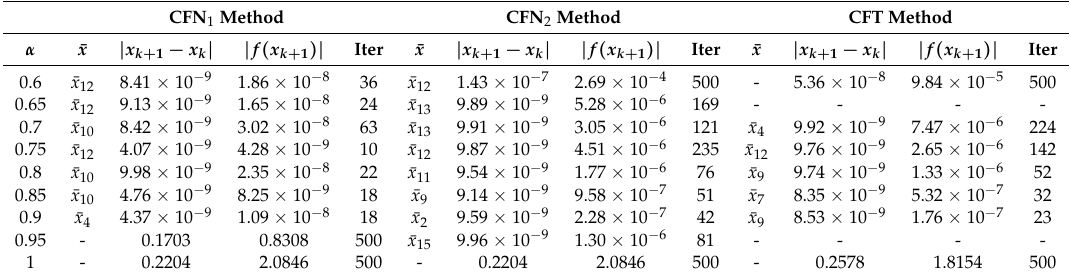
Table 6. Fractional Newton and Traub-type results for f 3 ( x ) with Caputo derivative and initial estimation x 0 =